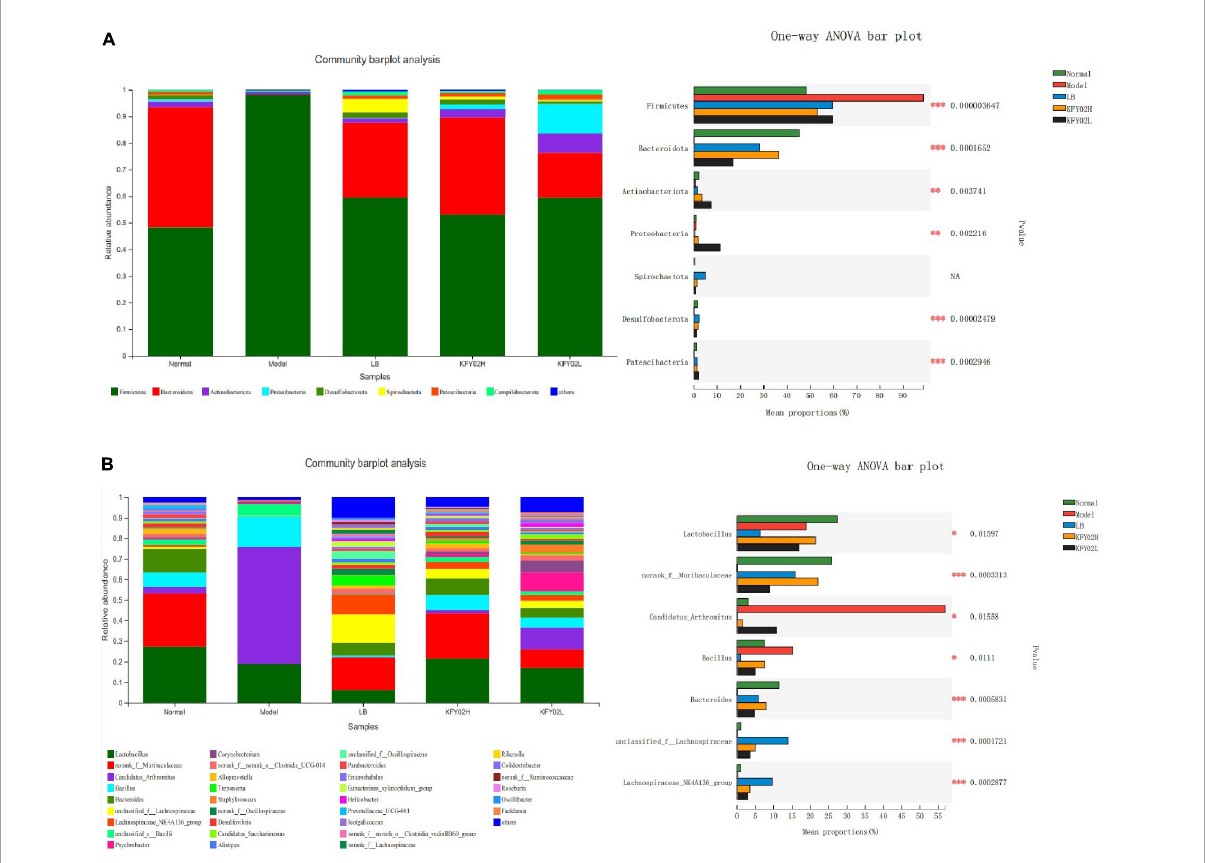
FIGURE4 Effect of LP-KFY02 on gut microbiota of constipation mice. (A) Mice feces bacterial communities at the phylum level and statistical analysis; (B) mice feces bacterial communities at the genus level and statistical analysis; ∗ 0.01 < p ≤ 0.05, ∗∗ 0.001 < p ≤ 0.01, ∗∗∗ p ≤ 0.001; LB: mice administered with 1 × 10 9 CFU/kg LB, KFY02H: mice administered with 1 × 10 9 CFU/kg LP-KFY02, KFY02L: mice administered with 1 × 10 8 CFU/kg LP-KFY02.